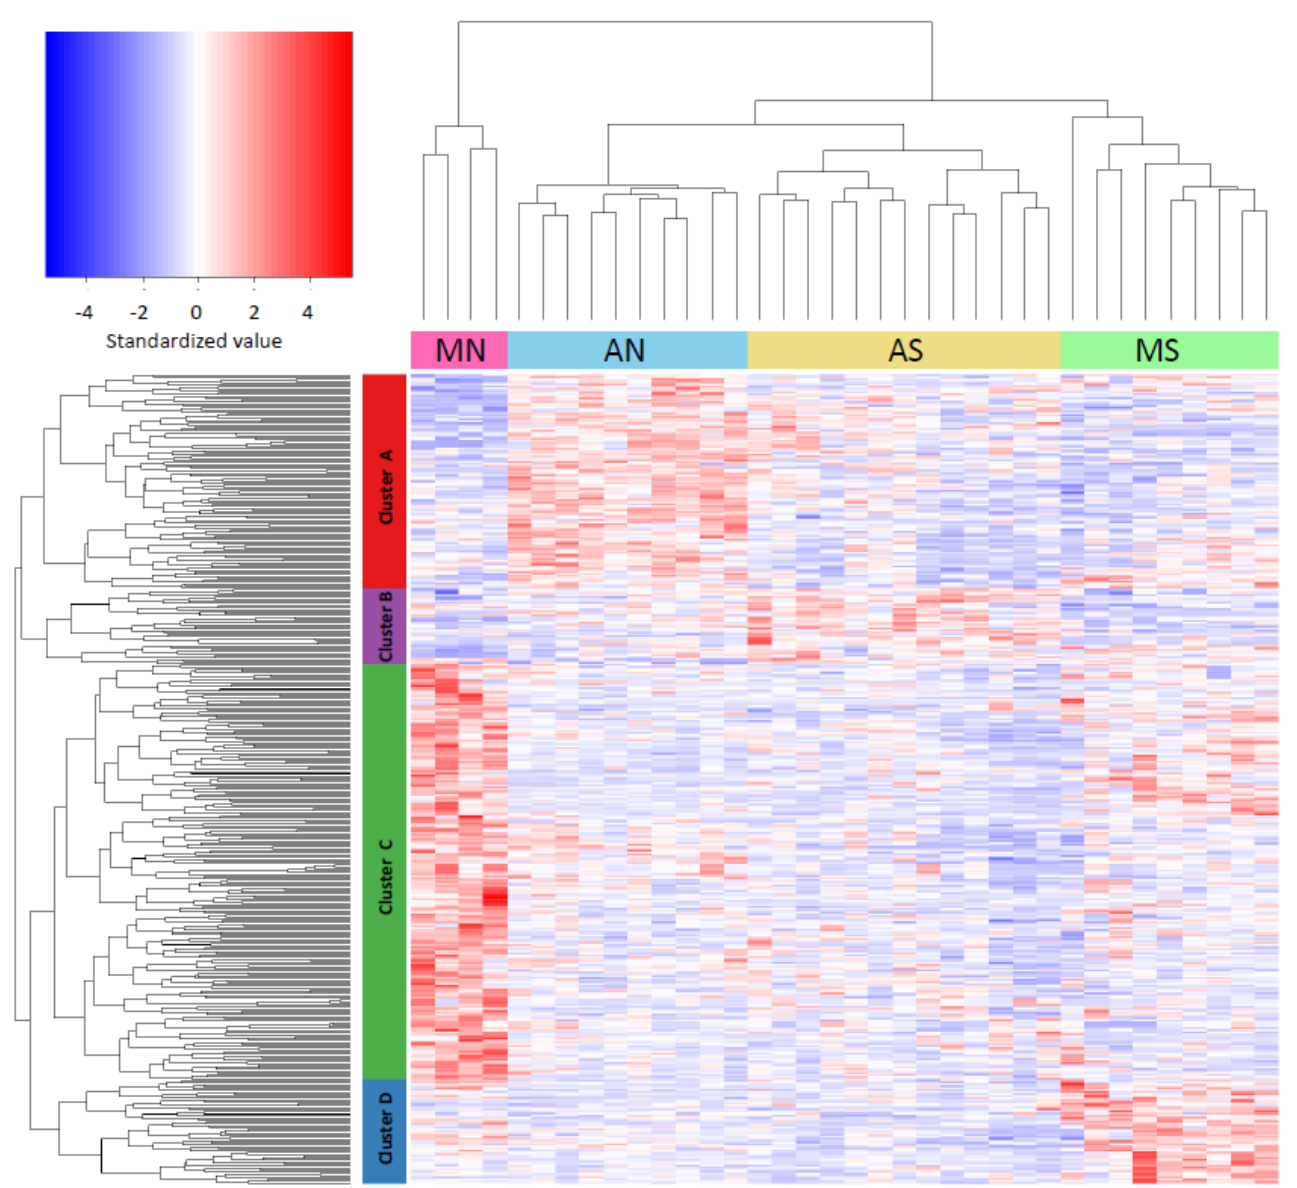
Figure 3. Heatmap of normalized gene expression and cluster analysis of distances between popula- tions and genes, based on the set of genes that were significant (5% FDR) in the one-way ANOVA.